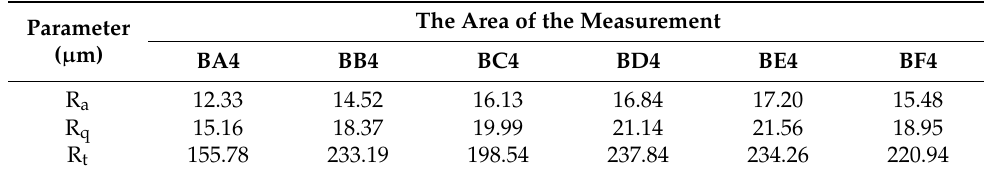
Table 6. The results of surface roughness measurements on the back